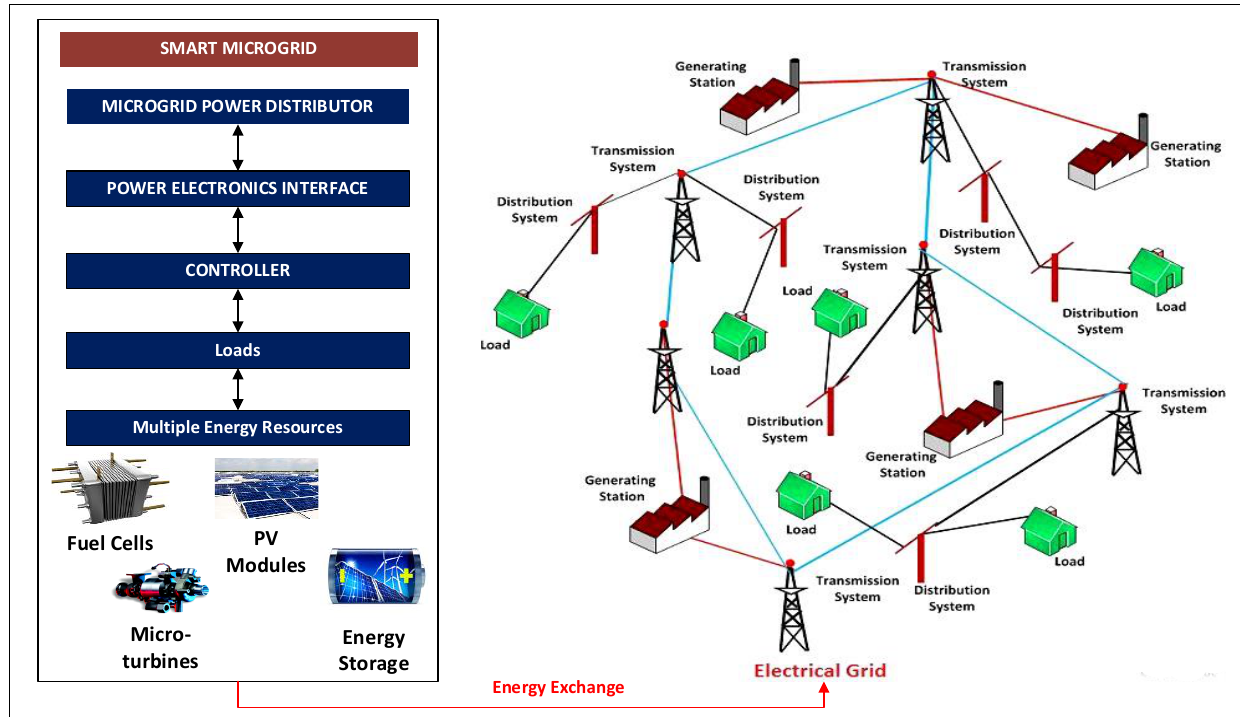
Figure 1. Schematic diagram of a microgrid.